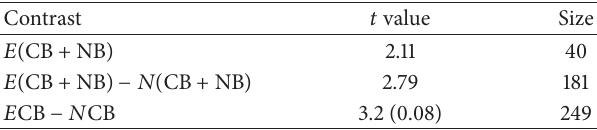
Figure 1: (a) Labeling of the mean T2 images of a representative individual subject in one session. Different colors (intensities) were used for different labels, and each color shows one label. Th denotes the thoracic and L denotes the lumbar vertebrae. (b) Illustration of the ROI, sagittal view. (c) Illustration of the ROI, axial view. (d) Illustration of the secondary mask. Table 1: Activity patterns within the